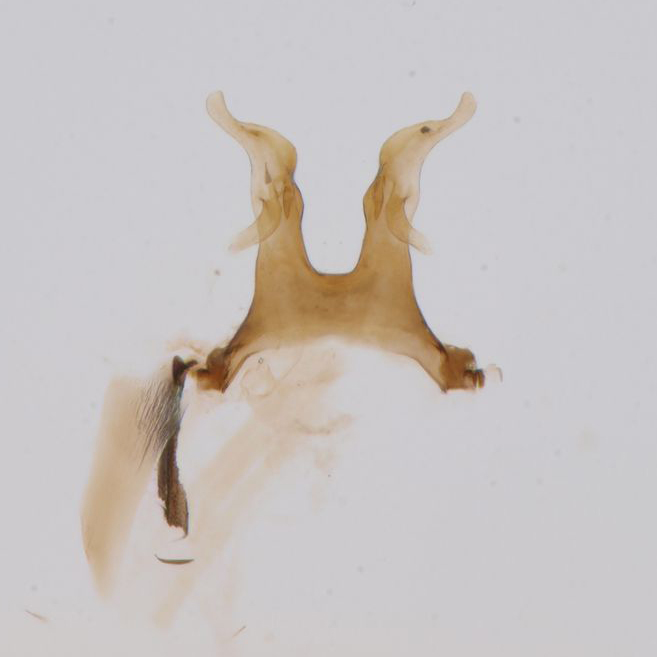
penis, ventral view